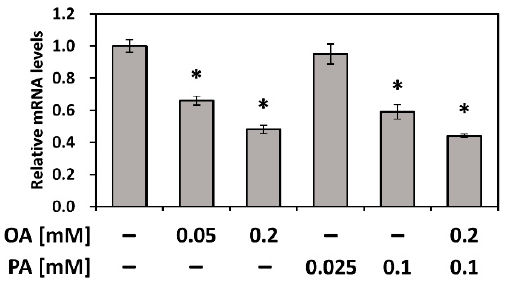
Figure 5. Hepatic PEDF is downregulated by fatty acids OA and PA. Hep3B cells were treated with various concentrations of fatty acids (OA, PA, or combined) for 24 h. PEDF expression was evaluated using quantitative RT-PCR. *, Statistically significant compared with the control group at p < 0.05.